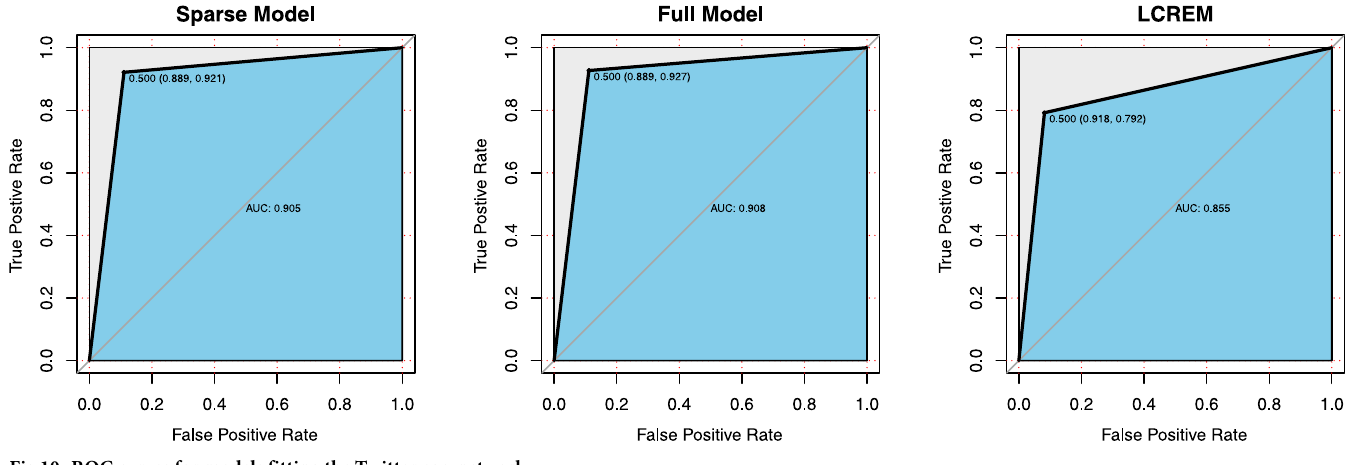
Fig 10. ROC curves for models fitting the Twitter